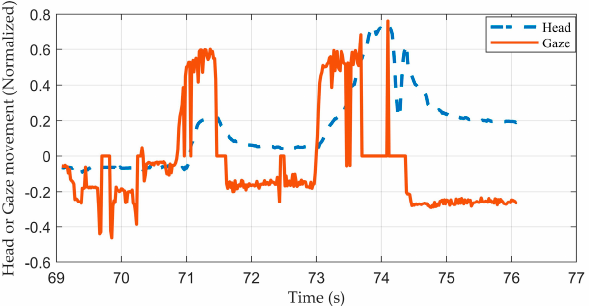
Figure 11. The head movement and gaze movement of subject 7 before changing lanes (occurred at about time = 75 s).